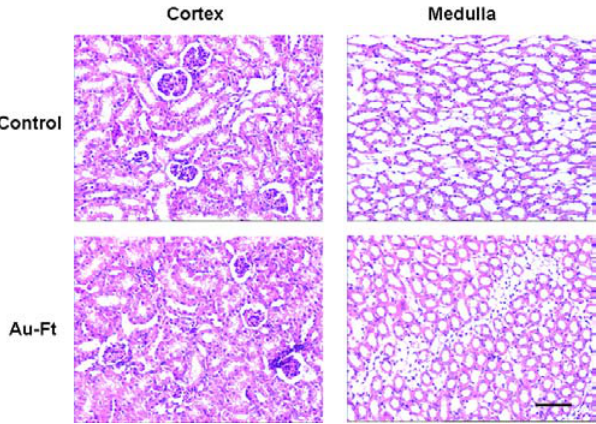
Fig. 1. Histological analysis of the kidney of nu/nu mice after Au – Ft treatment. Au – Ft (¯nal blood concentration 5.0 (cid:1) mol/ L) or saline control were injected into nu/nu mice. About 5 h after the treatment, mice were sacri¯ced, organs were ¯xed and embedded in para±n blocks and sectioned at 5 (cid:1) m. The bright- ¯eld images of H&E staining sections were acquired with an Olympus IX71 Inverted microscope equipped with a Sony DXC-390P color CCD camera. The scale bar is 200 (cid:1) m.